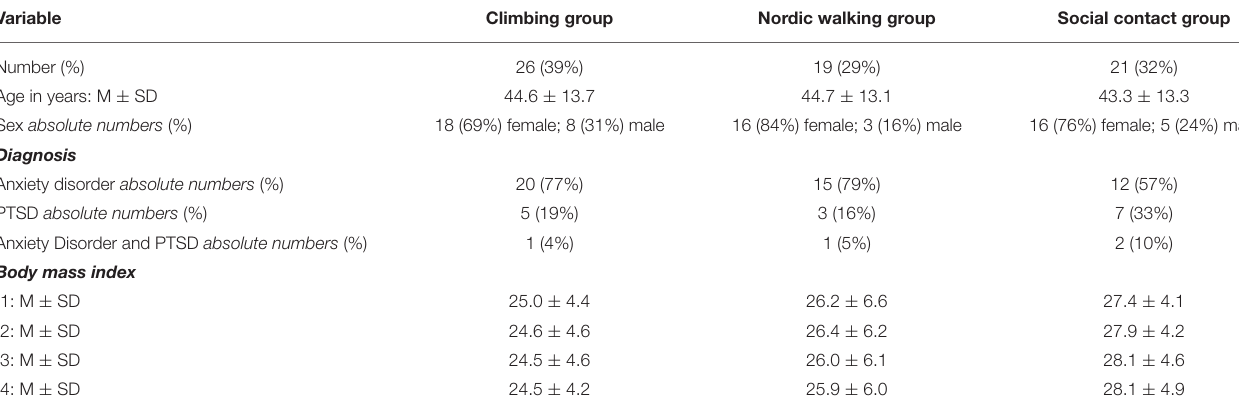
TABLE 1 | Sociodemographic and health-related characteristics of participants. Variable Climbing group Nordic walking group Social contact group